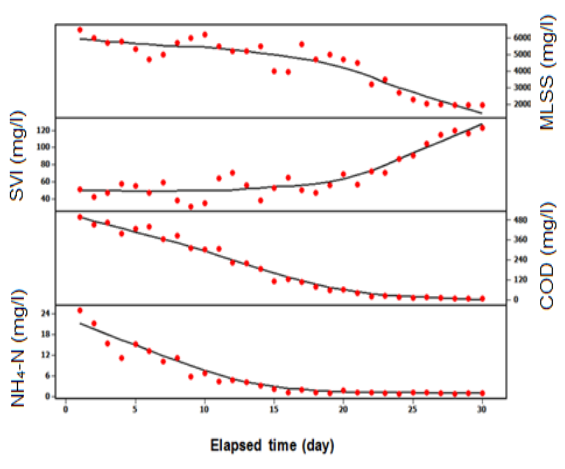
Figure 2. Variations in chemical oxygen demand (COD) and ammonium versus variations in sludge volume index (SVI) and mixed liquid suspended solid (MLSS) during acclimation period (Initial COD concentration = 500 mg/l, initial ammonium concentration = 25 mg NH